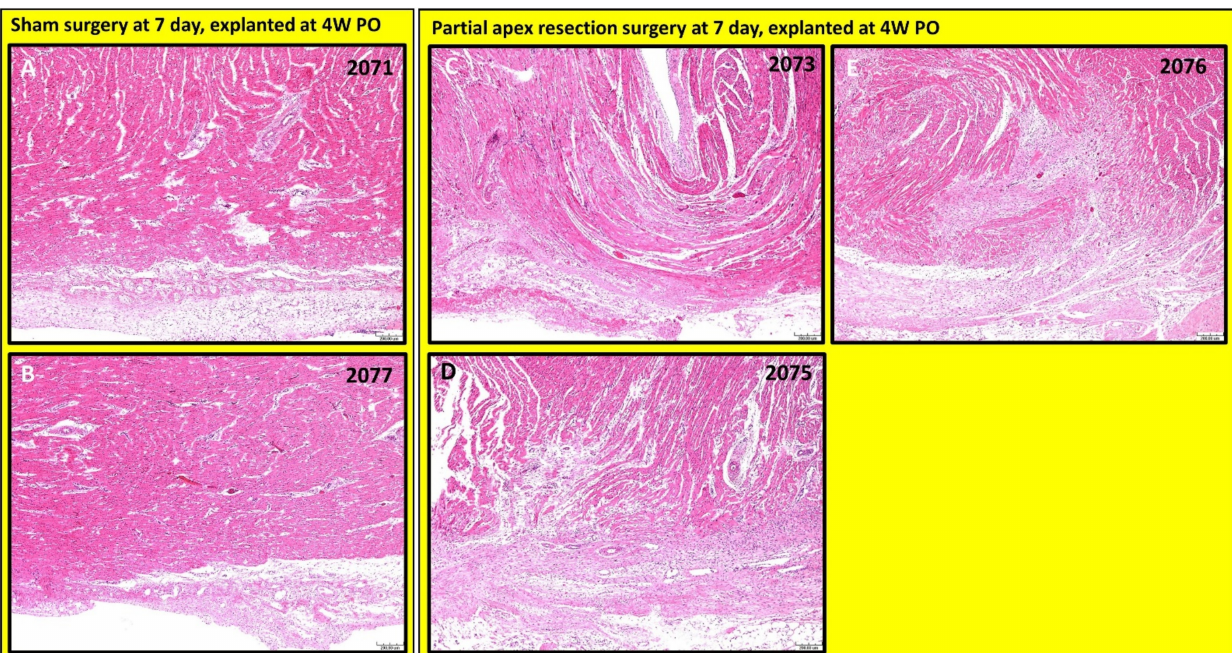
Figure 9. Partial apex resection surgery at seven days and heart explanted at 4W PO-Hematoxylin and Eosin (H & E) histology of seven-day control hearts and seven-day surgery hearts. Heart explants were obtained four weeks post-operation (4W PO). ( A ) Seven-day control (sham) heart from piglet #2071. ( B ) Seven-day control (sham) heart from piglet #2077. ( C ) Seven-day surgery heart from piglet #2073. ( D ) Seven-day surgery heart from piglet #2075. ( E ) Seven-day surgery heart from piglet #2076. Histological images were taken at 4 × magnification (Scale bar = 200 µ m). H & E: pink–cytoplasm; blue–nuclei; intense